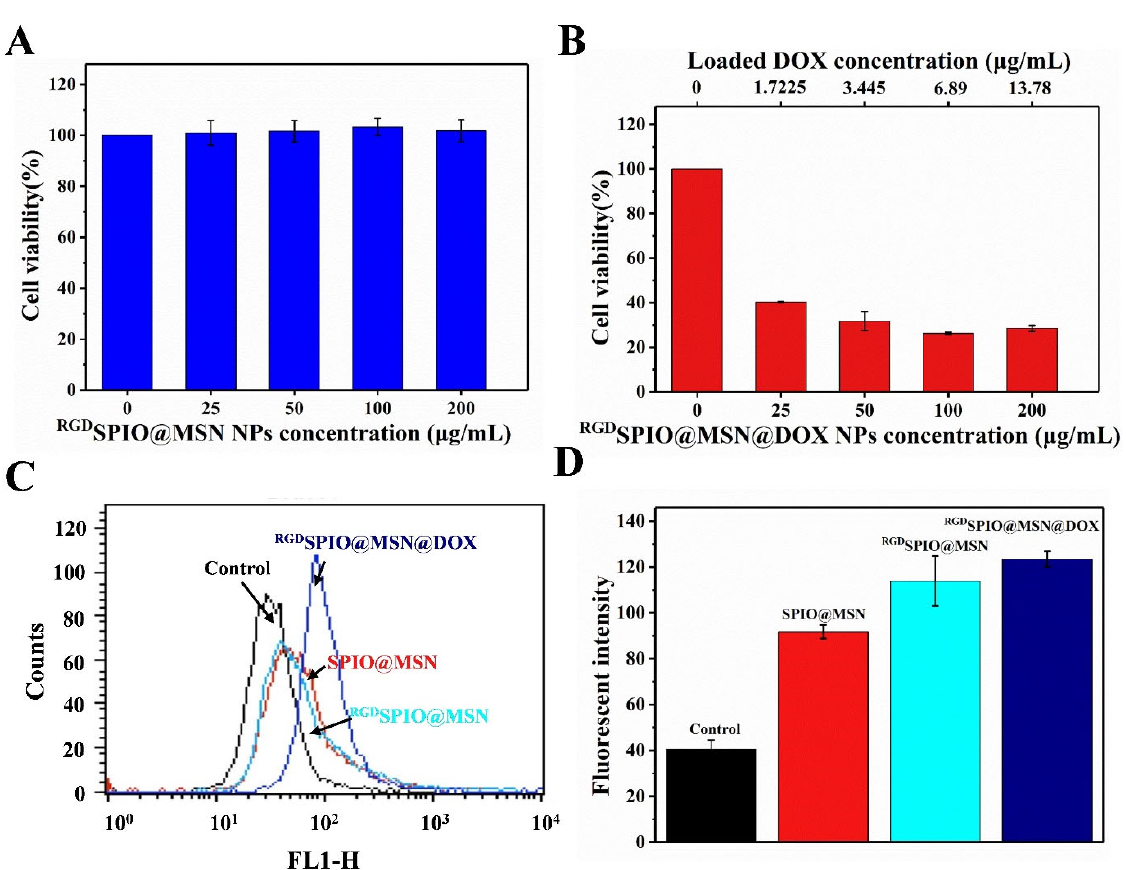
Figure 5. ( A ) Assay of cell viability after treatment for 24 h with RGD SPIO@MSN NPs and ( B )